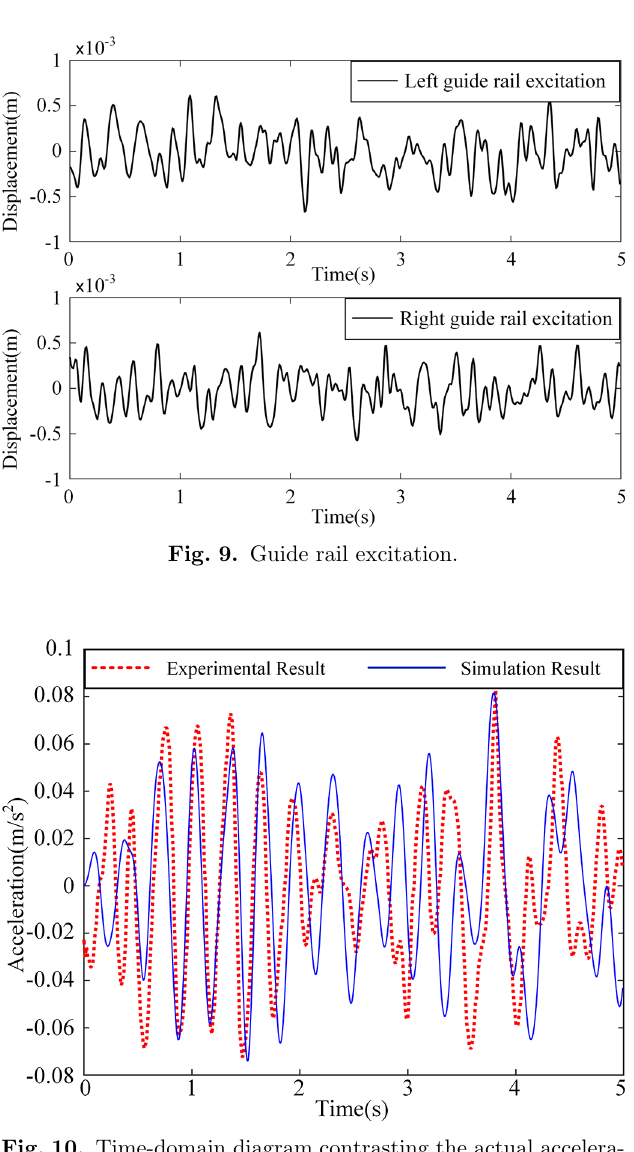
Fig. 10. Time-domain diagram contrasting the actual accelera- tion and the simulated acceleration of the